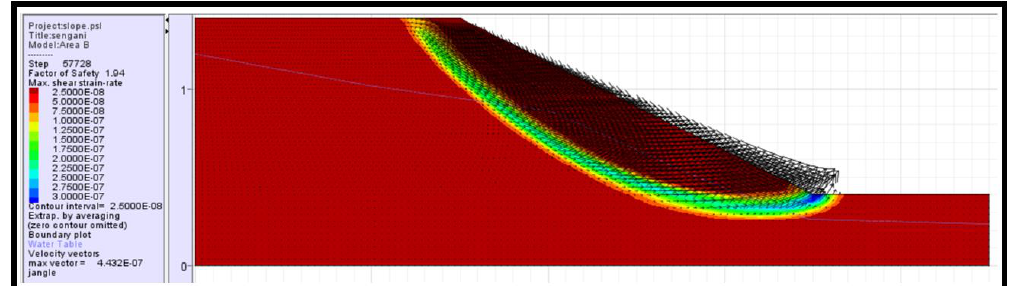
Figure 23. Simulated FoS of the silt clay soil slope using FLACSlope in sunny to rainy conditions with water table with 1000 m 3 volume of water. Note that maximum shear strain simulated ranges between 2.500 × 10 −8 to 4.432 × 10 −7 .